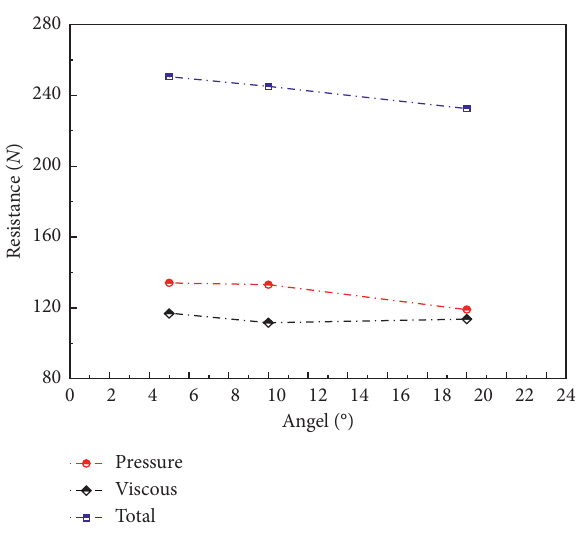
Figure 7: Resistance variation chart.